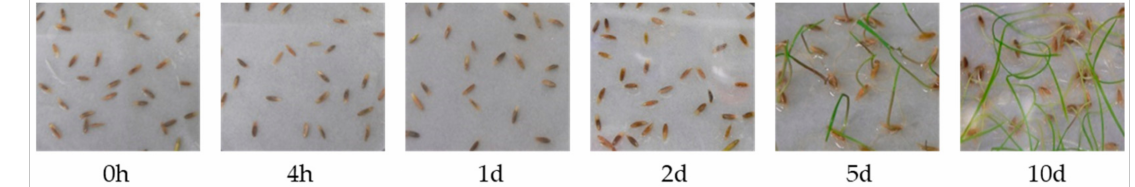
Figure 1. The six stages of seed germination used for analysis of the endophyte transcriptome in planta. Time points examined were 0 h, 4 h, 1 d, 2 d, 5 d, and 10